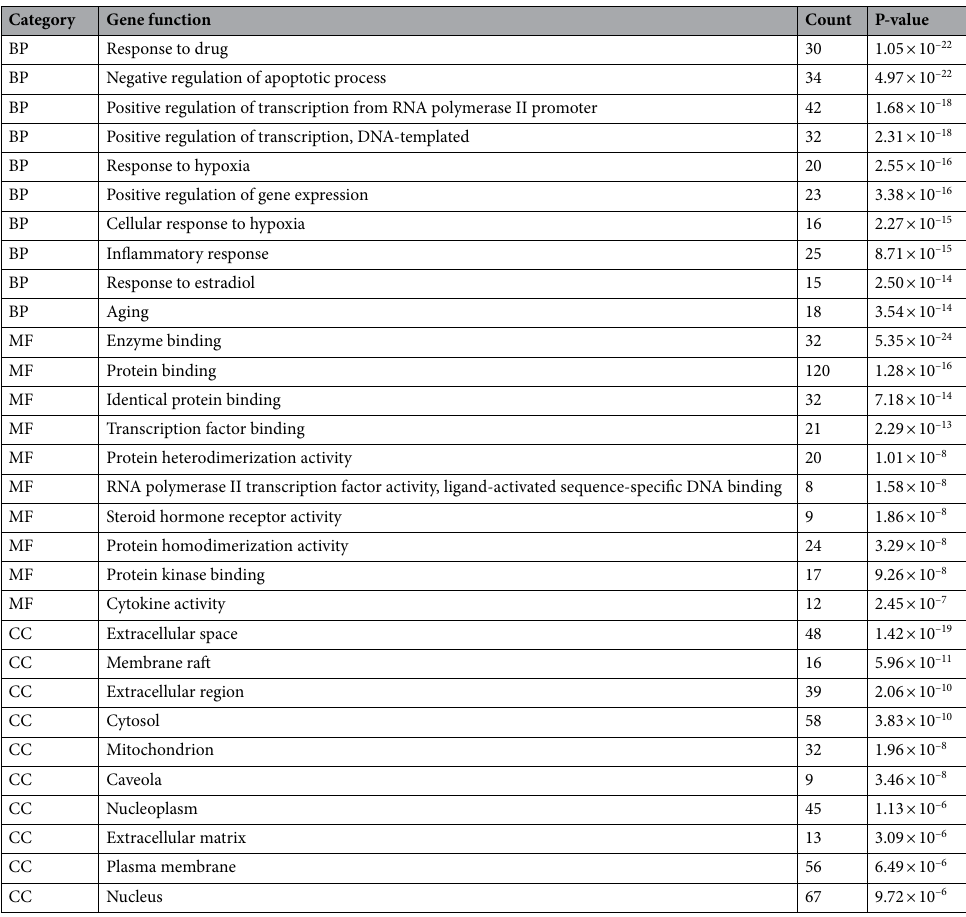
Table 2. GO analysis of core targets (top